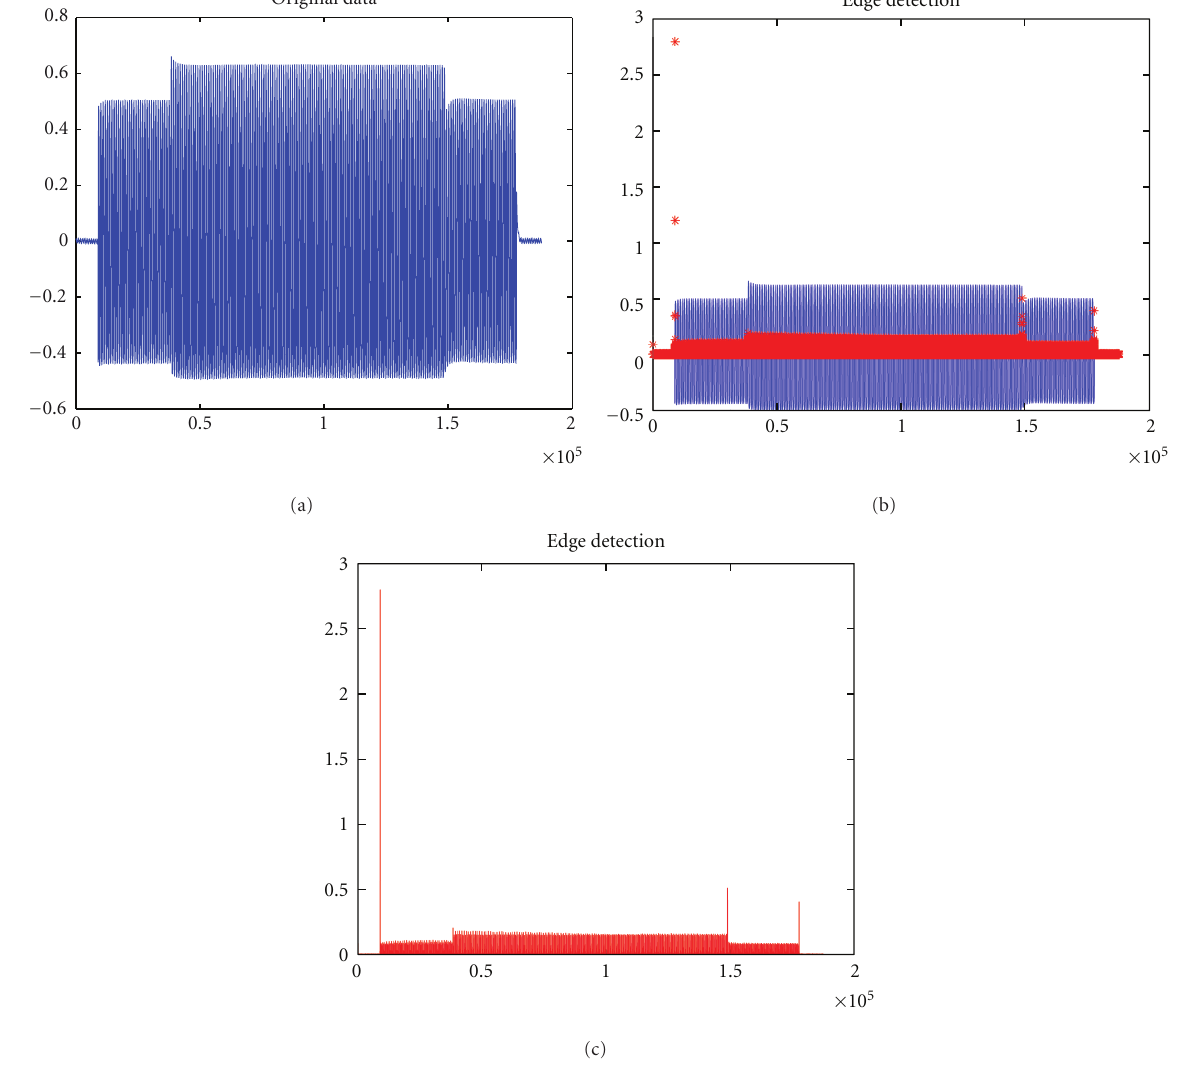
Figure 4: The original data and edge analysis of Kettle + Oven.